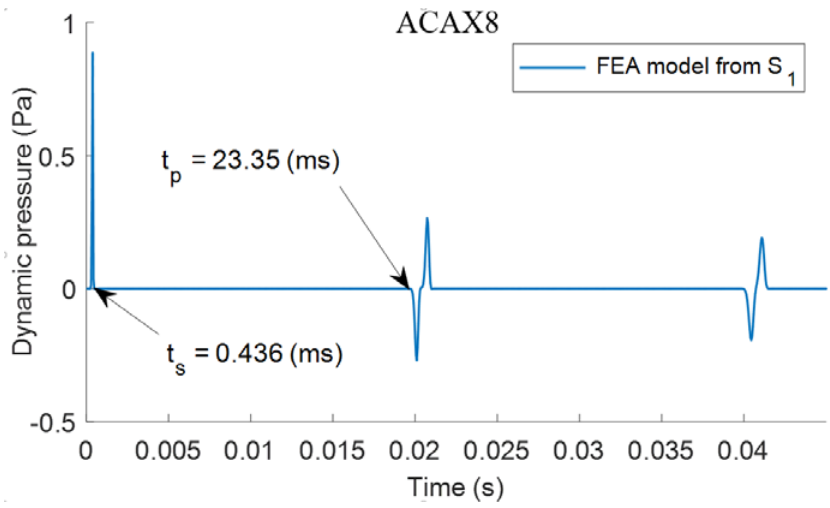
using ACAX8 element 𝑟𝑟 1